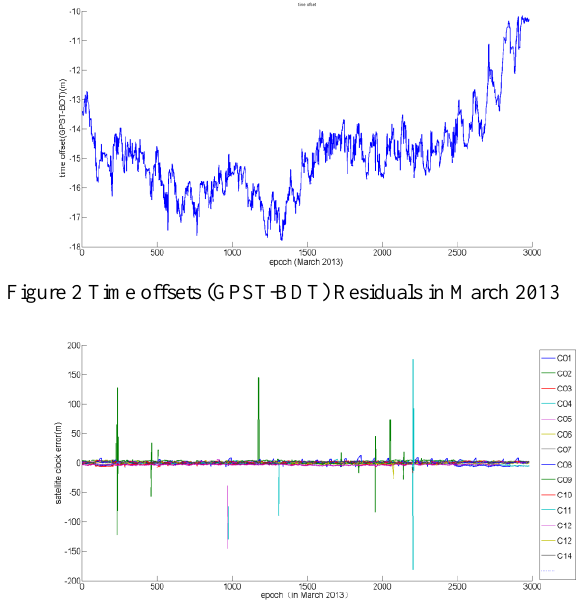
Figure 3 Satellite Clock errors (in March